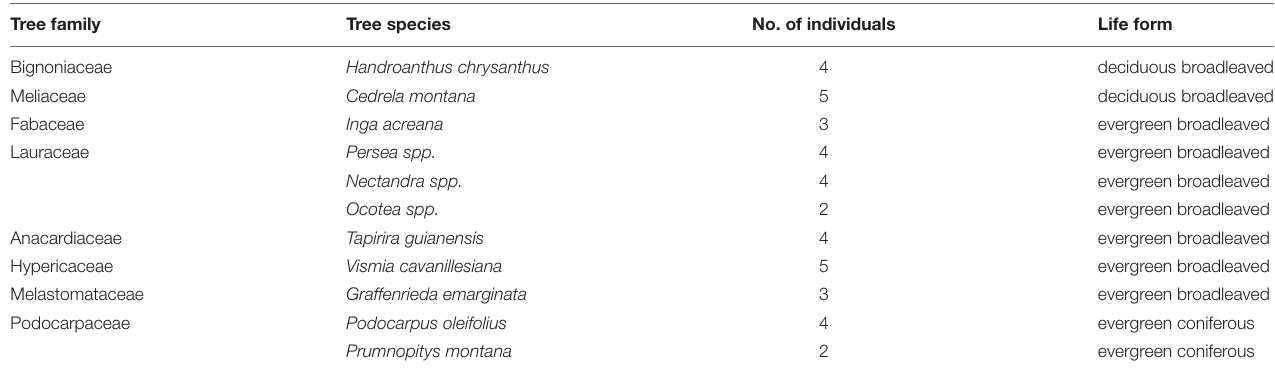
TABLE 1 | Characteristics of studied tree species equipped with electronic dendrometers. Tree